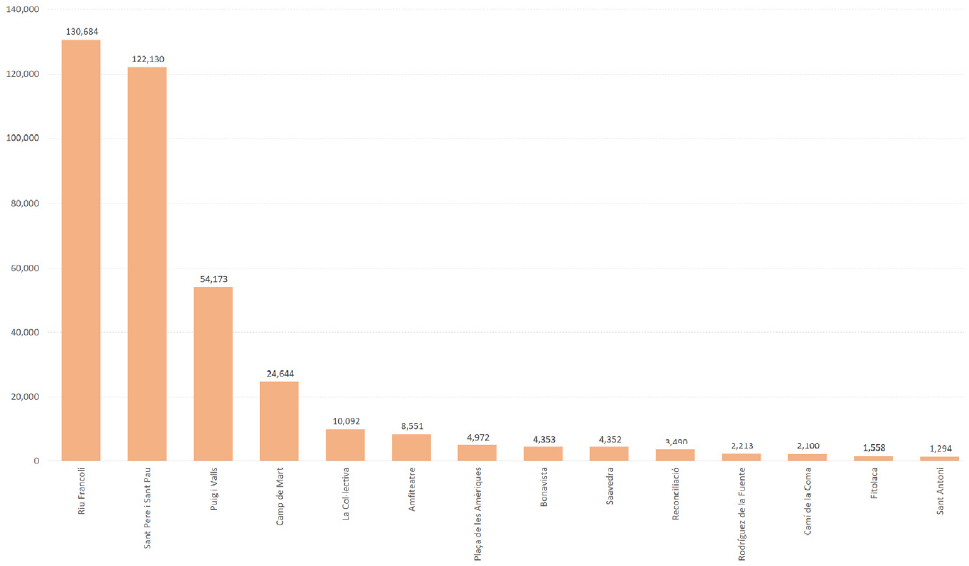
Figure 5. Surface area of the urban parks in Tarragona, in sqm. Source: own work .